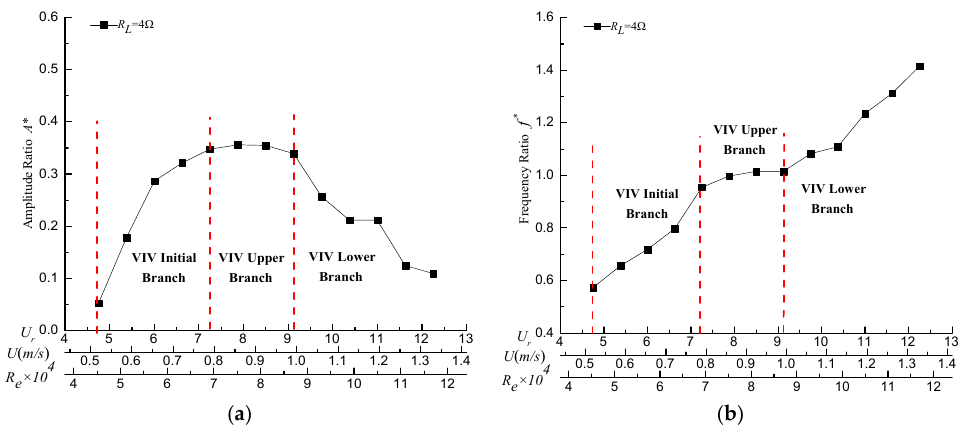
Figure 8. Vortex-induced vibration (VIV) oscillation characteristics ( R L = 4 Ω , ζ = 0.347): ( a ) response of the amplitude ratio; ( b ) response of the frequency ratio.